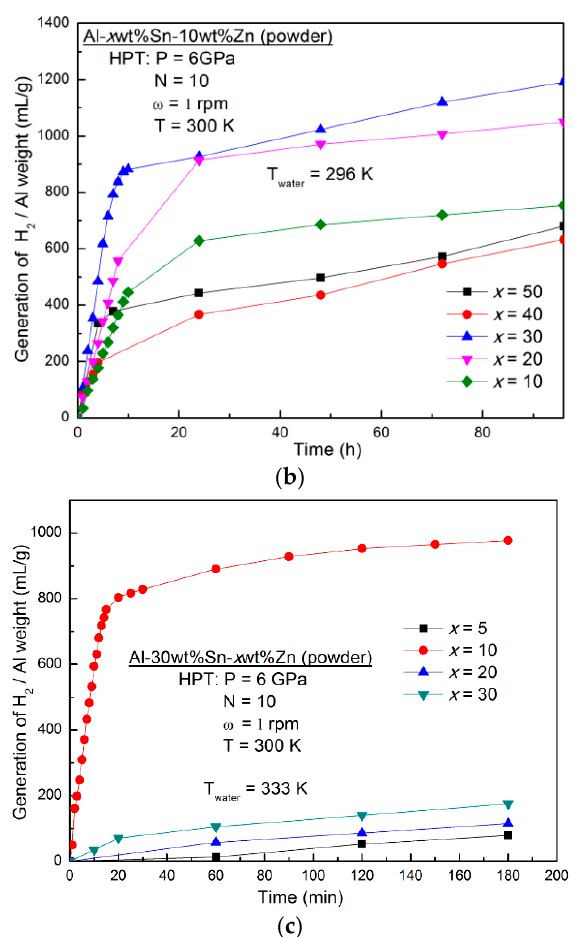
Figure 1. Hydrogen generation against time for ( a ) Al-50wt %Sn-10wt %X alloys (X: Sn, Zn, Fe, Ni, Cu, Mg, Si), ( b ) Al- x wt %Sn-10wt %Zn alloys ( x = 10, 20, 30, 40, 50), and ( c ) Al-30wt %Sn- x wt %Zn